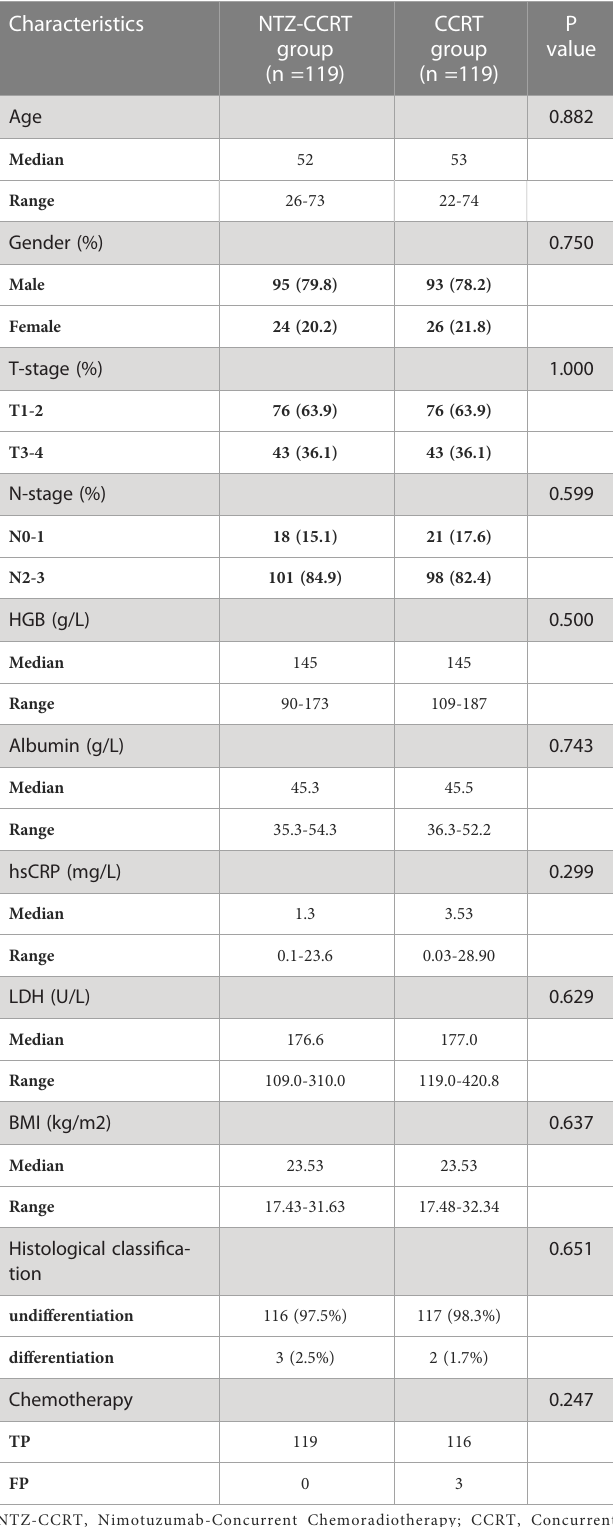
TABLE 1 Characteristics of NPC patients treated with or without nimotuzumab.